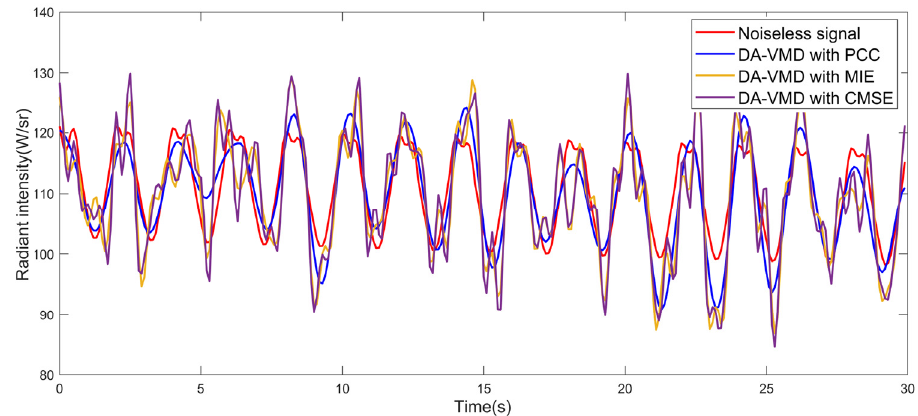
Figure 11. Denoising signal of different selection criteria of effective IMFs. Table 5. Performance of different selection criteria of effective IMFs at NEI = 60 × 10 - 14 W·m - 2 .